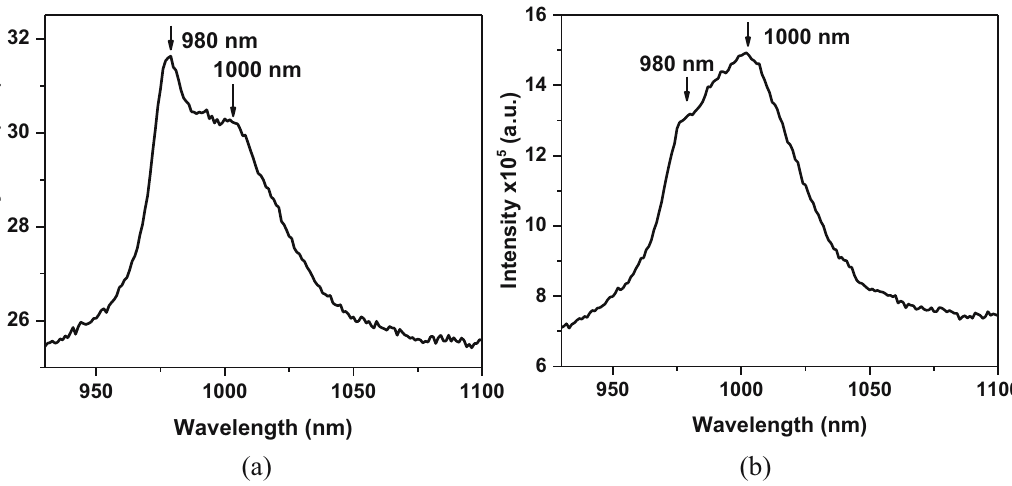
Figure 7: ( a ) Down - conversion emission spectra of phosphors ( a ) NaY 0.88 F 4 :Yb 3 + 0.1 ,Tm 3 + 0.02 and ( b ) NaY 0.78 F 4 :Yb 3 + 0.2 ,Tm 3 + 0.02 pumped with Ar - ion laser at 488 nm ( power ∼ 75.5 mW )